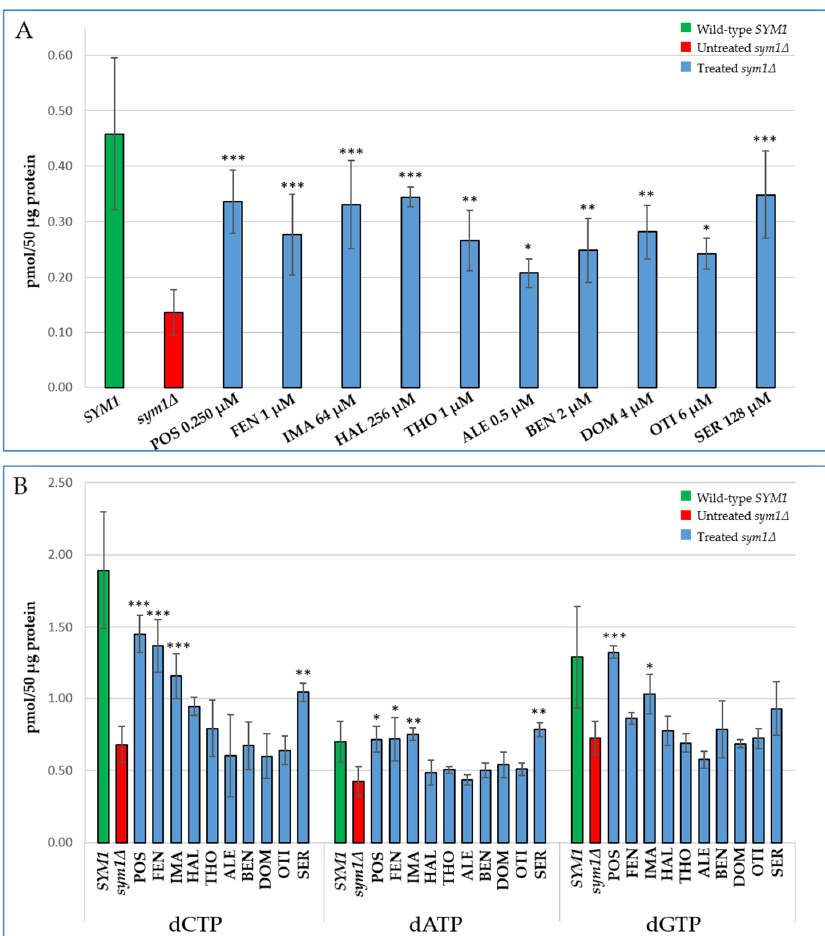
Figure 4. Effect of the identified drugs on mitochondrial dTTP ( A ), dCTP, dATP and dGTP ( B ) amounts of the sym1∆ null mutant strain. Cells were grown for 24 h at 37 °C in SC medium supplemented with 0.6% glucose and 2% ethanol. The concentration of each drug is specified in panel A. Data are represented as the mean of at least three values ± SD. Statistical analyses were performed using ANOVA followed by a Bonferroni’s post hoc test comparing treated (blue bars) versus the untreated mutant (red bar) in which the compound vehicle DMSO was added: * p < 0.05; ** p < 0.01; *** p < 0.001.